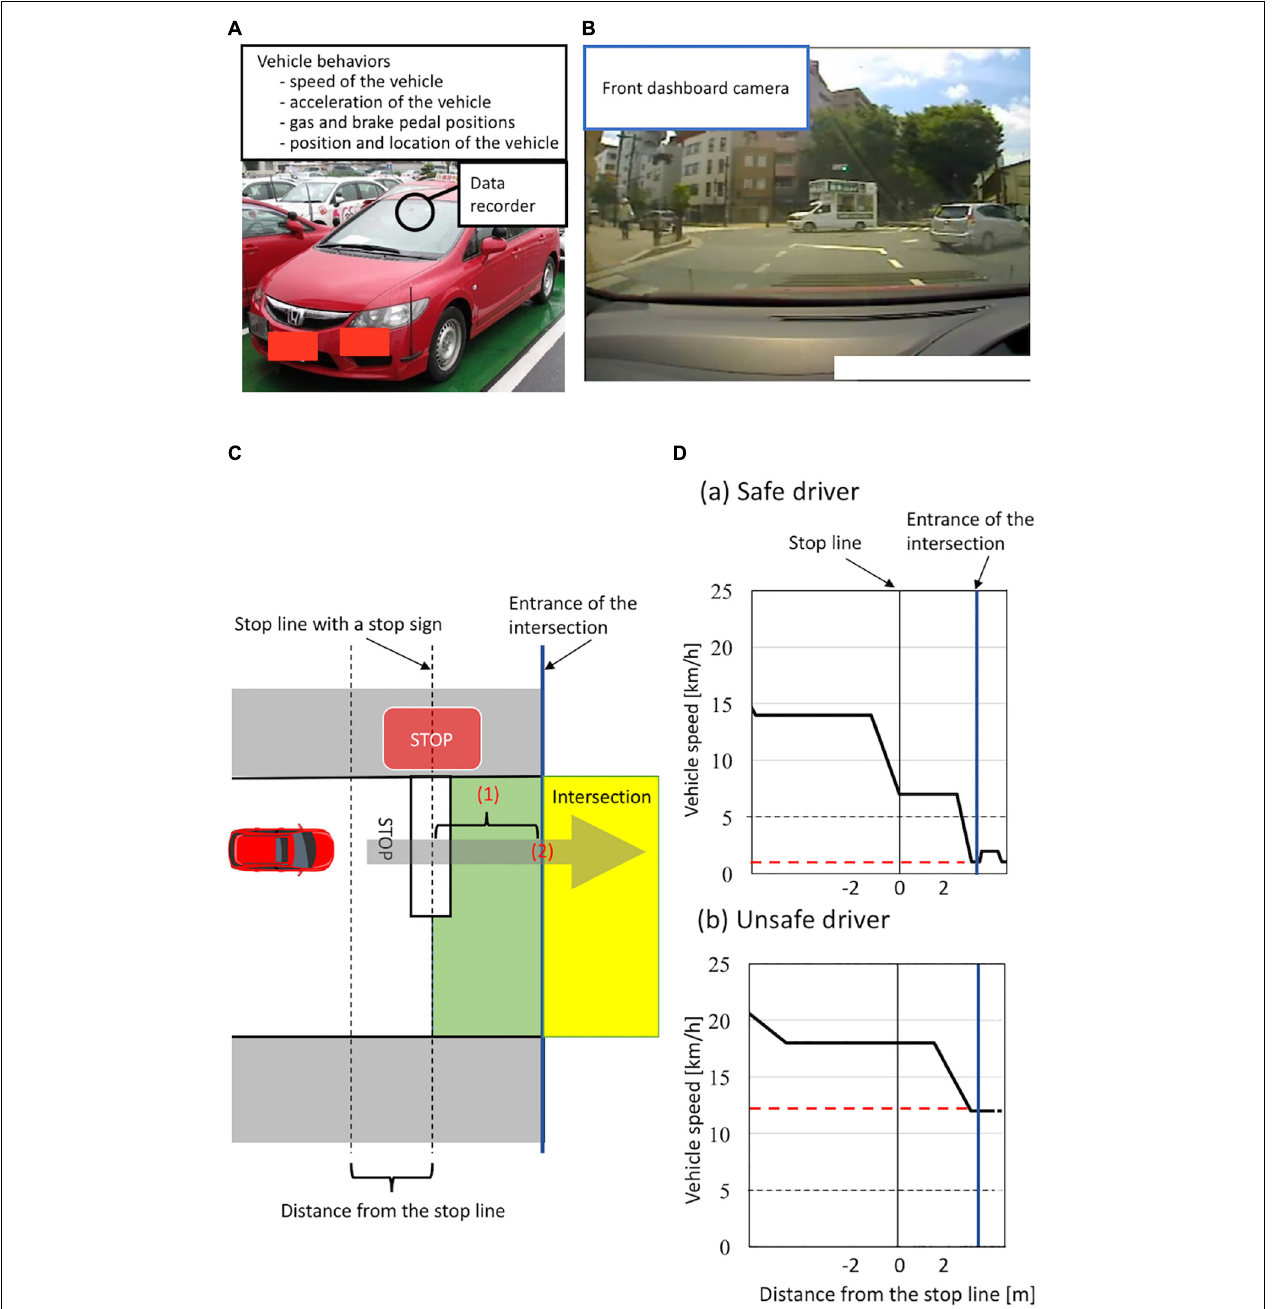
FIGURE 1 | (A–B) Instrumented automatic vehicle for evaluating vehicle behaviors using a data recorder (Tough More-eye S manufactured by Finefit Design, Aichi, Japan) and charge-coupled device (CCD) cameras. (A) The data recorder provides the speed and acceleration of the vehicle and the positions of gas and brake pedal. The data recorder was placed on the front dashboard. (B) The front dashboard CCD camera filmed surrounding traffic and lanes. (C–D) Classification of a safe or unsafe driver based on vehicle behaviors. (C) The definition of the area of the intersection having a stop sign. Vehicles are driven on the left side of the road in Japan. The area from the stop line to the entrance of the intersection is shown in green. The area of the intersection is shown in yellow. The entrance of the intersection is shown by a blue line. To evaluate drivers’ behavior, we measured (1) the minimum speed of the vehicle between the stop line and the entrance of the intersection and (2) the speed of the vehicle when the front of the car was at the entrance of the intersection. (D) Schema of velocity distribution patterns measured using the instrumented vehicle. Figures show examples of velocity distribution patterns of (a) a safe driver and (b) an unsafe driver. The minimum speed of a vehicle from the stop line to the entrance of the intersection is shown by a red line. We classified all participants into two groups according to (1) whether the minimum speed of the vehicle between the stop line and the entrance of the intersection was less than 5 km/h and (2) whether the speed of the vehicle when the front of the car was at the entrance of the intersection was less than 5 km/h. We classified participants who met both criteria as safe drivers, and classified those who did not as unsafe drivers.